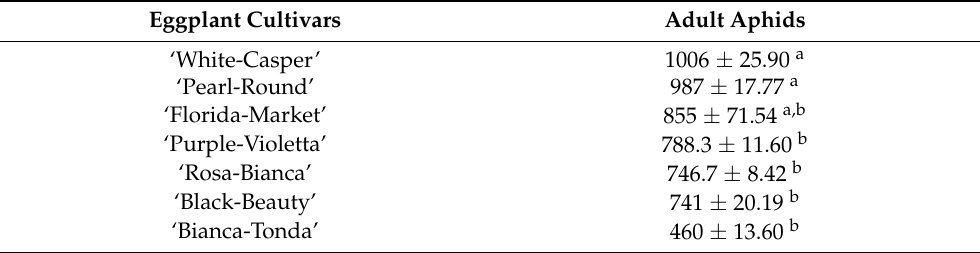
Table 1. Mean number ( ± Standard Error (SE)) of Myzus persicae on fourteen eggplant cultivars for screening the test in the greenhouse